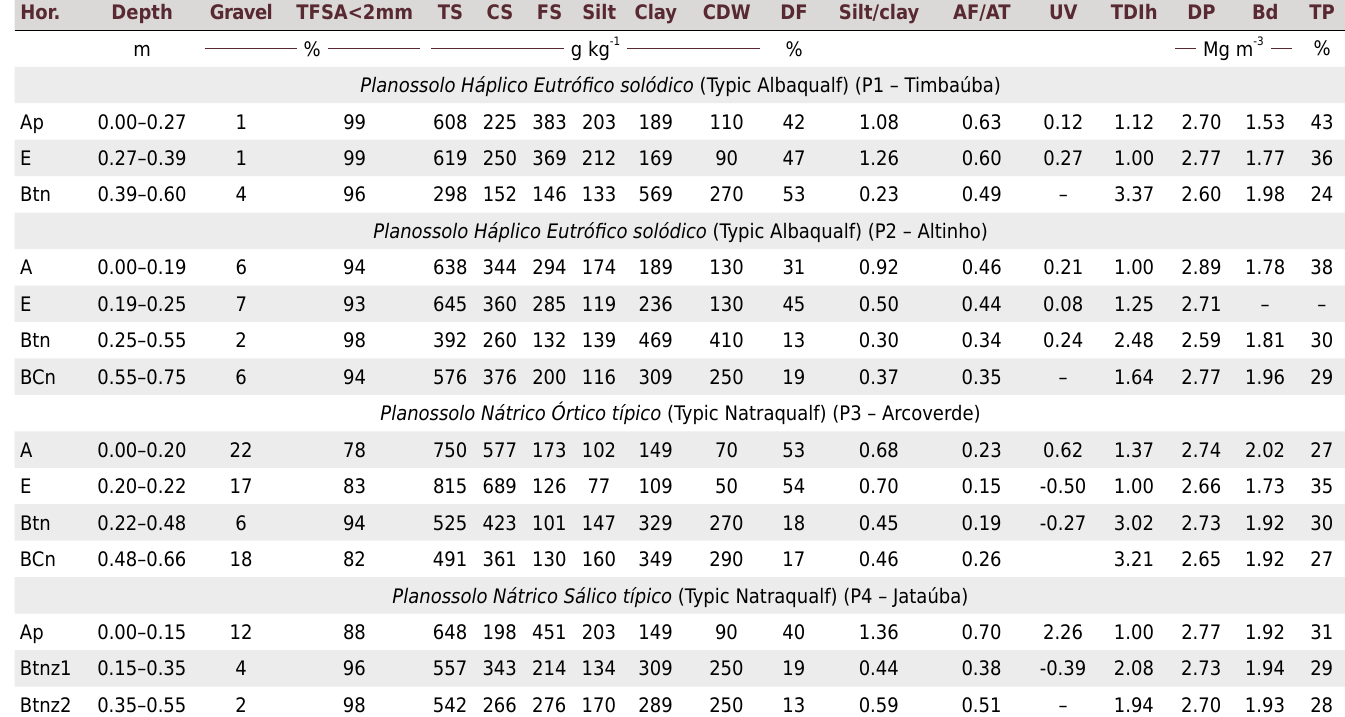
Table 2. Physical analysis of four Planosols in different geo-environmental conditions in the State of Pernambuco Hor.